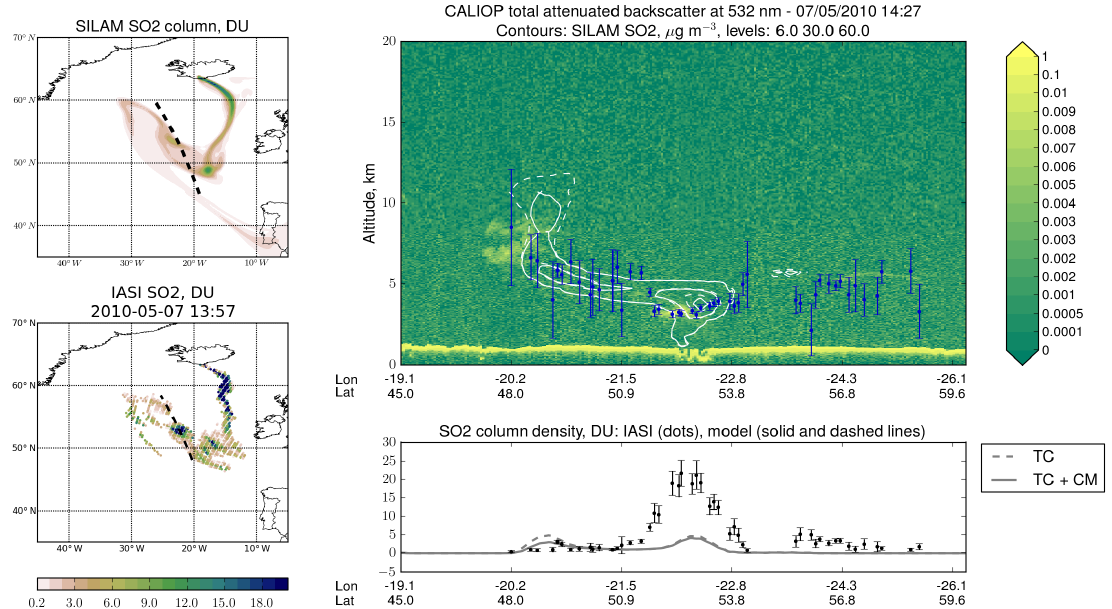
Figure 12. CALIOP total attenuated backscatter, simulated SO 2 concentration (contour levels indicated on the figure title) and collocated IASI plume height retrievals at ∼ 14:00UTC on 7 May 2010. The solid lines and contours correspond to inversion using total column and plume height retrievals; dashed lines and contours correspond to inversion using total column retrievals only. The modelled and retrieved column densities are shown in maps on the left and as a 1-D plot along the CALIOP track on the bottom. The full CALIOP track segment is marked in the map of simulated SO 2 columns (top left), the track segment where the collocated IASI data are extracted is shown in the map of retrieved SO 2 columns (bottom left). The model SO 2 columns shown in the map are from the inversion using both total column and plume height retrievals.